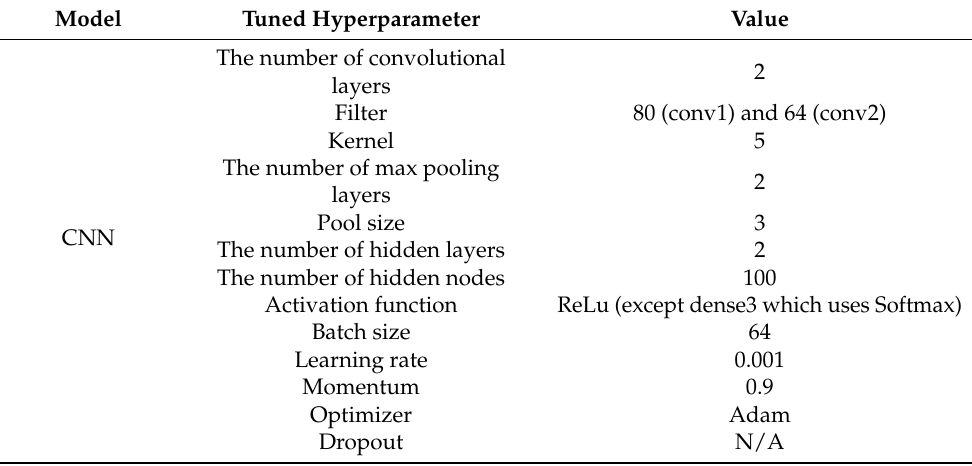
Table 6. List of tuned hyperparameters for detecting combined detects in the first approach. Model